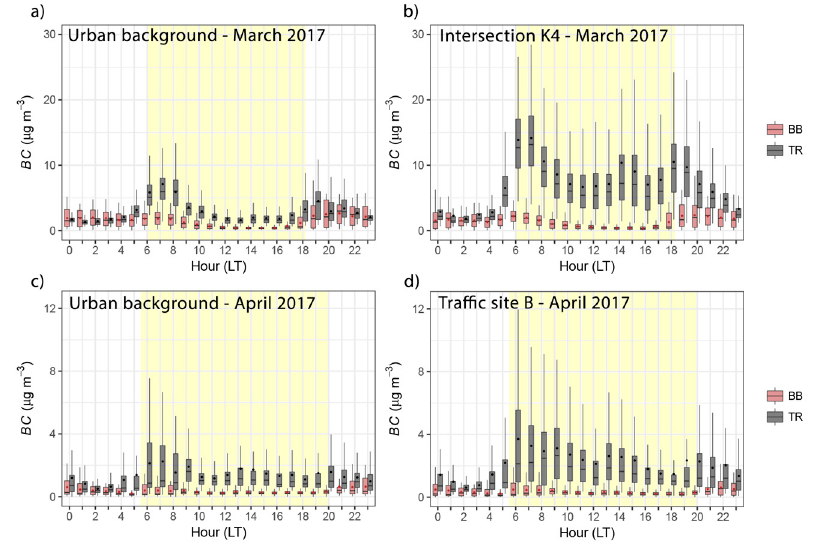
Figure 6. Diurnal variation (working days) of traffic (TR) and biomass burning (BB) BC concentration at the urban background location ( a , c ), and at traffic sites: intersection K4 ( b ) and site B ( d ) during measurement campaign in March and April 2017. Averages (1 h) are presented as box plots (box: range between 25th and 75th percentile, central line: median, dot: mean, upper and lower whiskers represent data within 1.5 × IQR (inter-quartile range) distance). Daylight duration in the period of measurements is highlighted in yellow. Time is presented in local time (LT). Note the different scales in March and April.